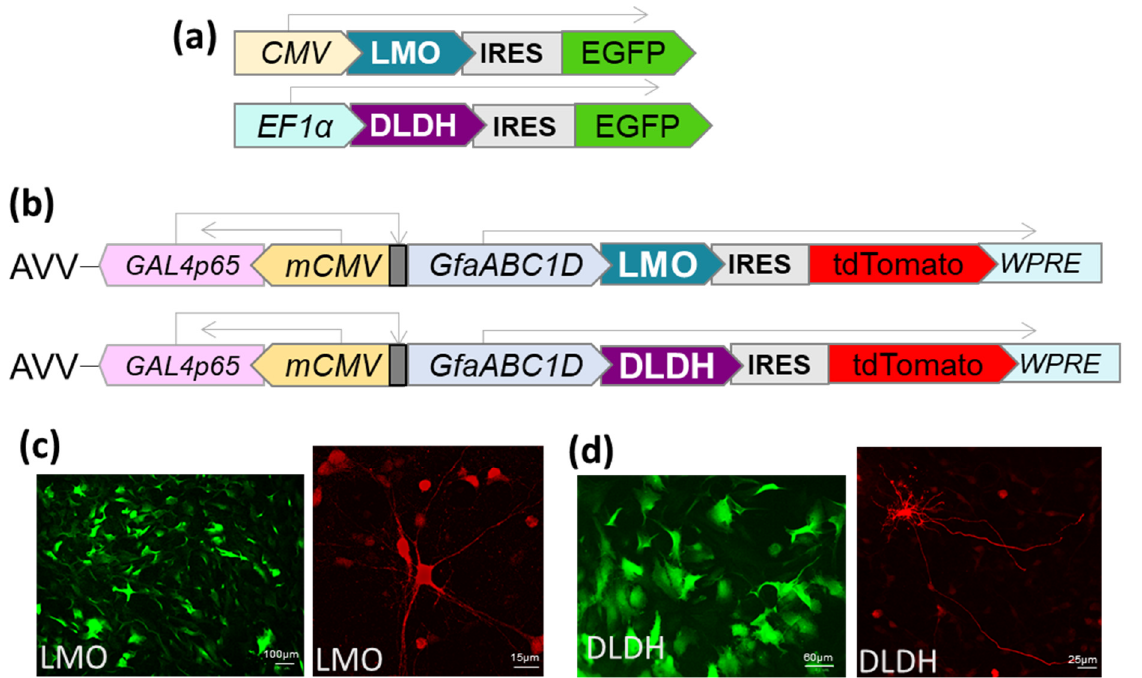
Figure 2. Expression of LMO and DLDH in mammalian cells. ( a ) Domain structure of the cassette for transfection of HEK293 cells with LMO and DLDH. The expression was driven by CMV or EF1 α promoter. Enhanced green fluorescent protein (EGFP) was cloned 3’ of an internal ribosome entry site (IRES). ( b ) A transcriptionally enhanced fragment of GFAP promoter (sGFAP, [16]) was employed to selectively target the expression of the enzymes to astrocytes. The bicistronic cassettes were introduced into an AVV backbone with tdTomato as a fluorescent marker. ( c ) Representative images of astrocytes in dissociated primary culture (left; scale bar 100 µm) or organotypic brainstem slices (right; scale bar 15 µm) transduced with AVV-sGFAP-LMO-IRES-tdTomato. ( d ) Representative images of astrocytes in dissociated primary culture (left; scale bar 60 µm) or organotypic brainstem slices (right; scale bar 25 µm) transduced with AVV-sGFAP-DLDH-IRES-tdTomato. The reporter was amplified by anti-RFP staining.